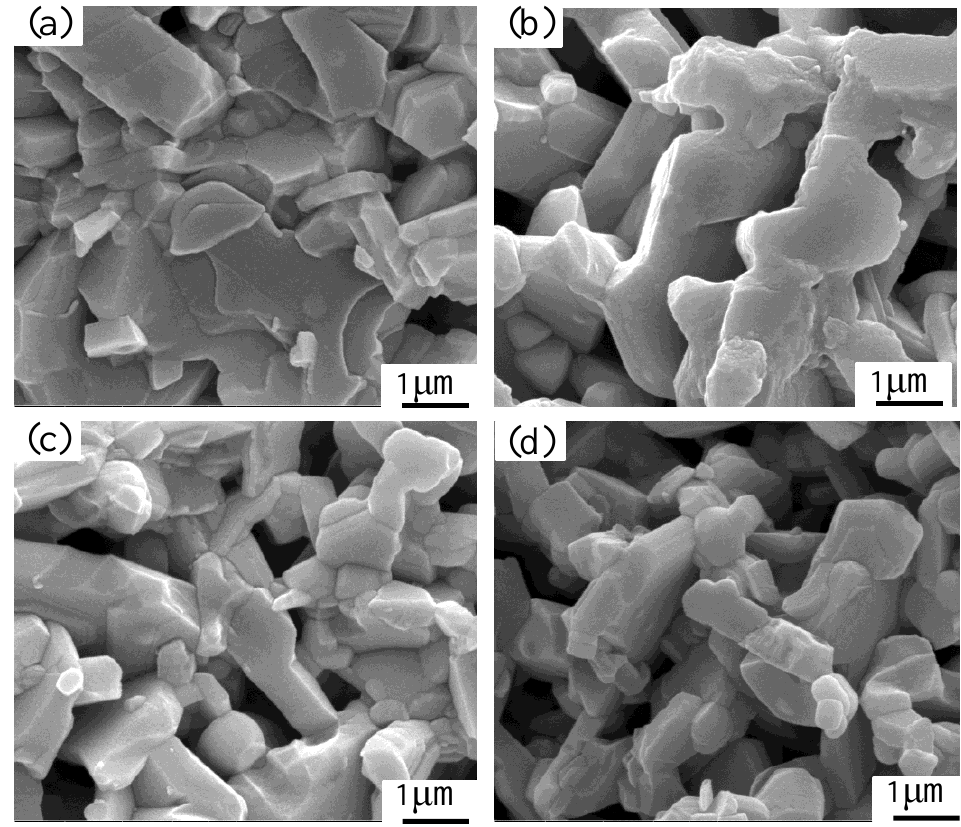
Figure 1. SEM images of the materials with different Sr 2+ ion substitution x values. ( a ) x = 0.0, ( b ) x = 0.2, ( c ) x = 0.4 and ( d ) x = 0.6.